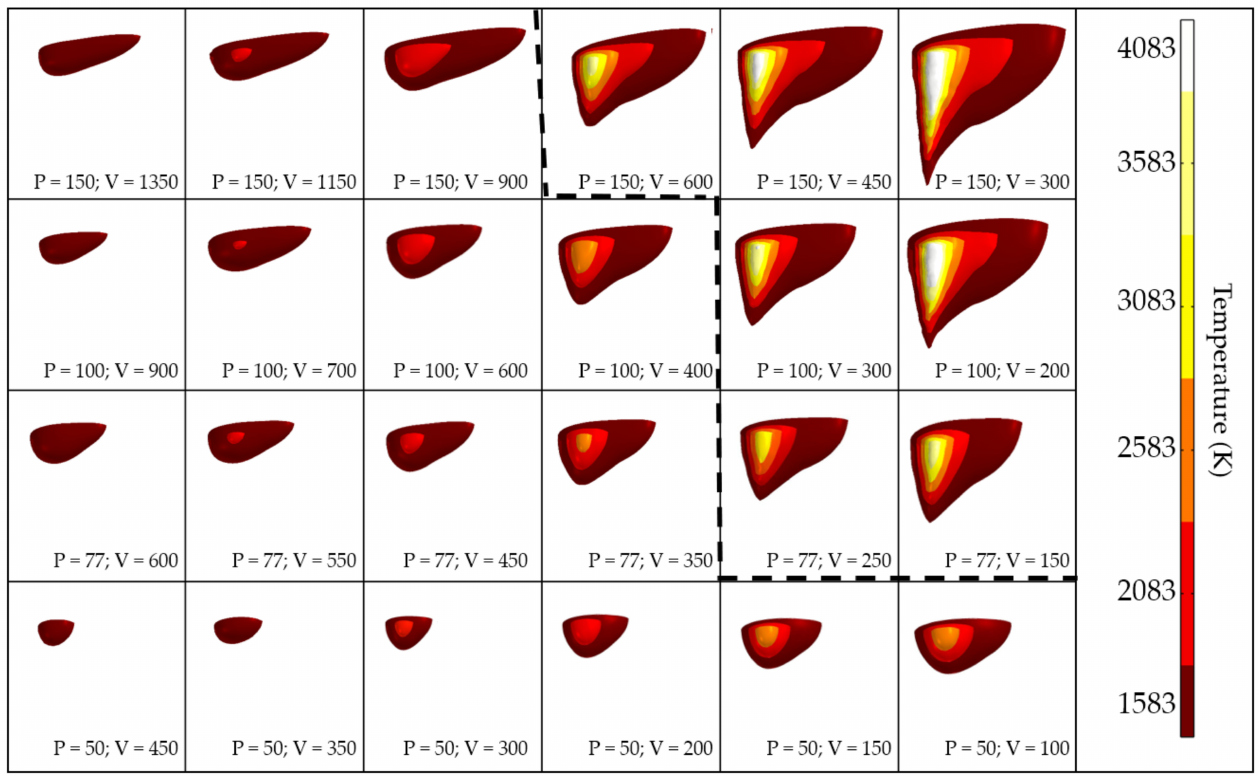
Figure 13. Evolution of the melt pool’s shape and temperature distribution with the process parameters. The dashed line divides the regimes into conductive ( left ) and keyhole ( right )